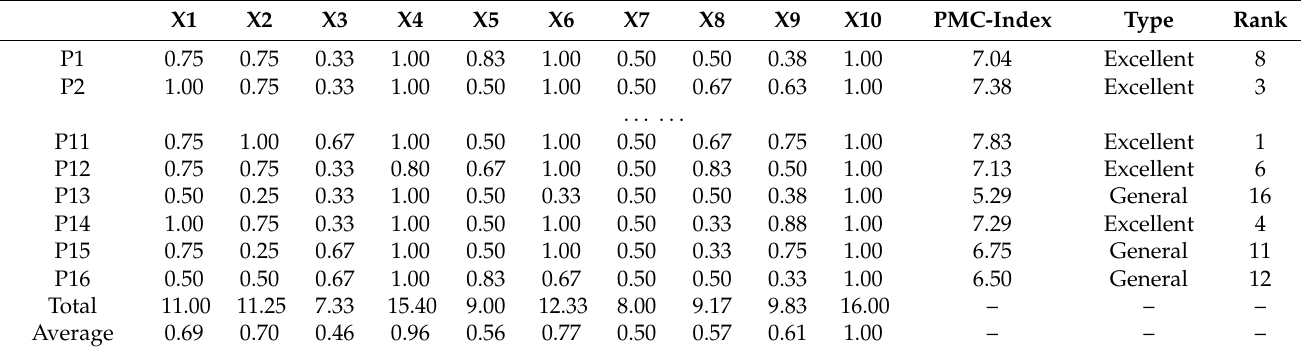
Table 5. Policy PMC-Index and